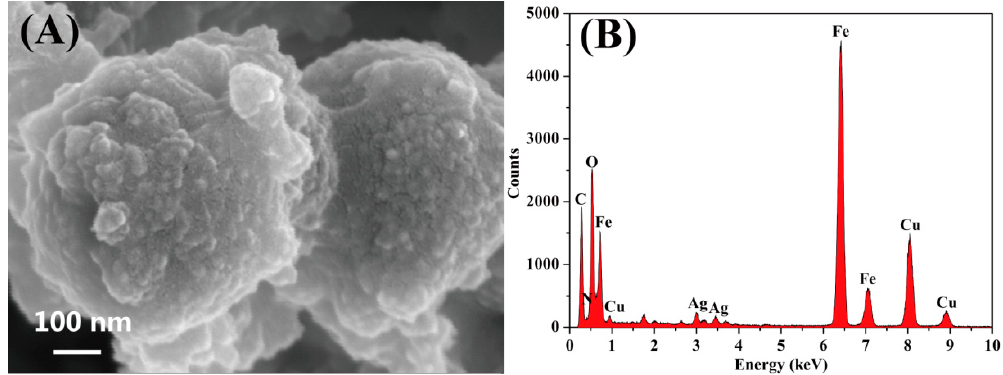
Figure 2. ( A ) Scanning electron microscope (SEM) image of CuFe 2 O 4 /Ag@COF; ( B ) energy-dispersive X-ray spectroscopy (EDX) pattern of CuFe 2 O 4 /Ag@COF.